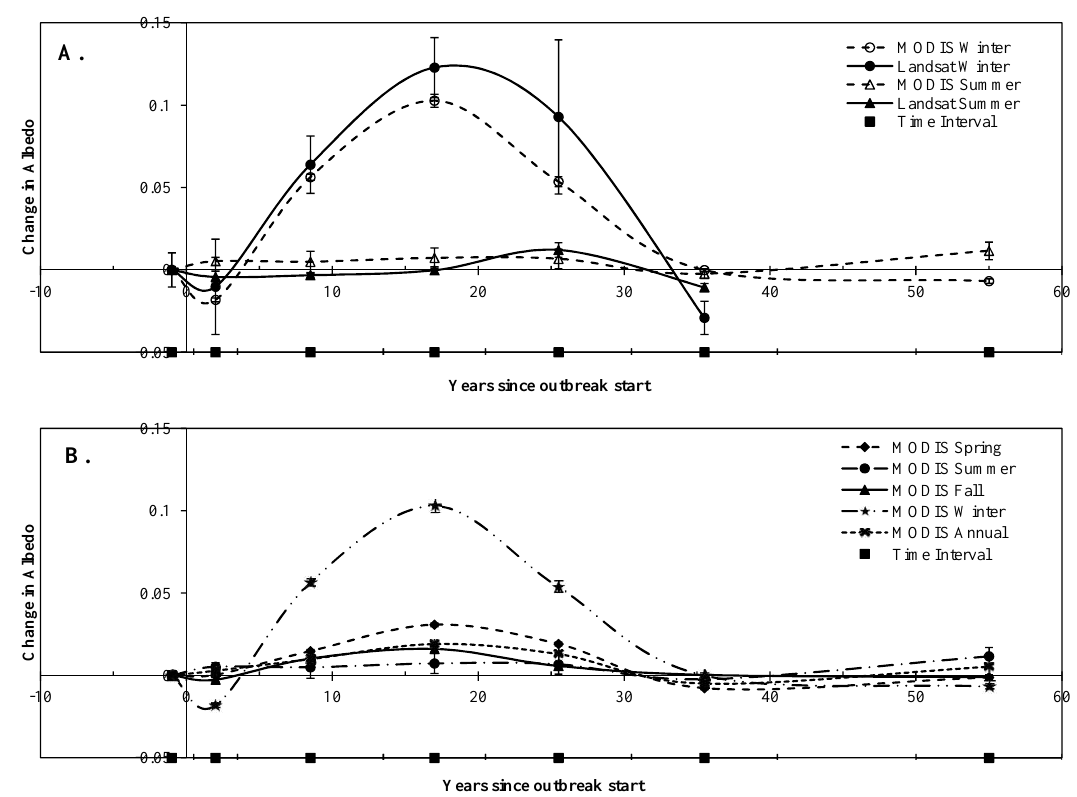
Fig. 2. (A) The MODIS versus Landsat change in winter and summer albedo with years since outbreak start. (B) The seasonal trend in change in albedo with years since outbreak start as derived from MODIS albedo. The time interval line indicates the number of years each point is averaged over. Error bars indicate plus and minus standard